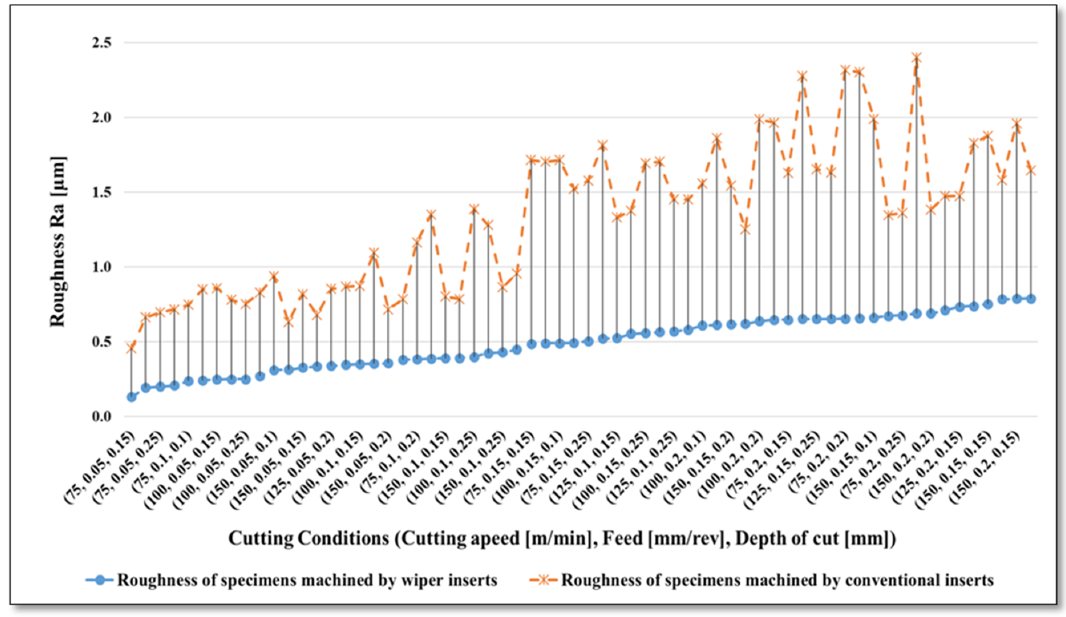
Figure 5. Resultant average roughness (Ra µ m) for AISI 4340 specimens machined by wiper and conventional inserts.